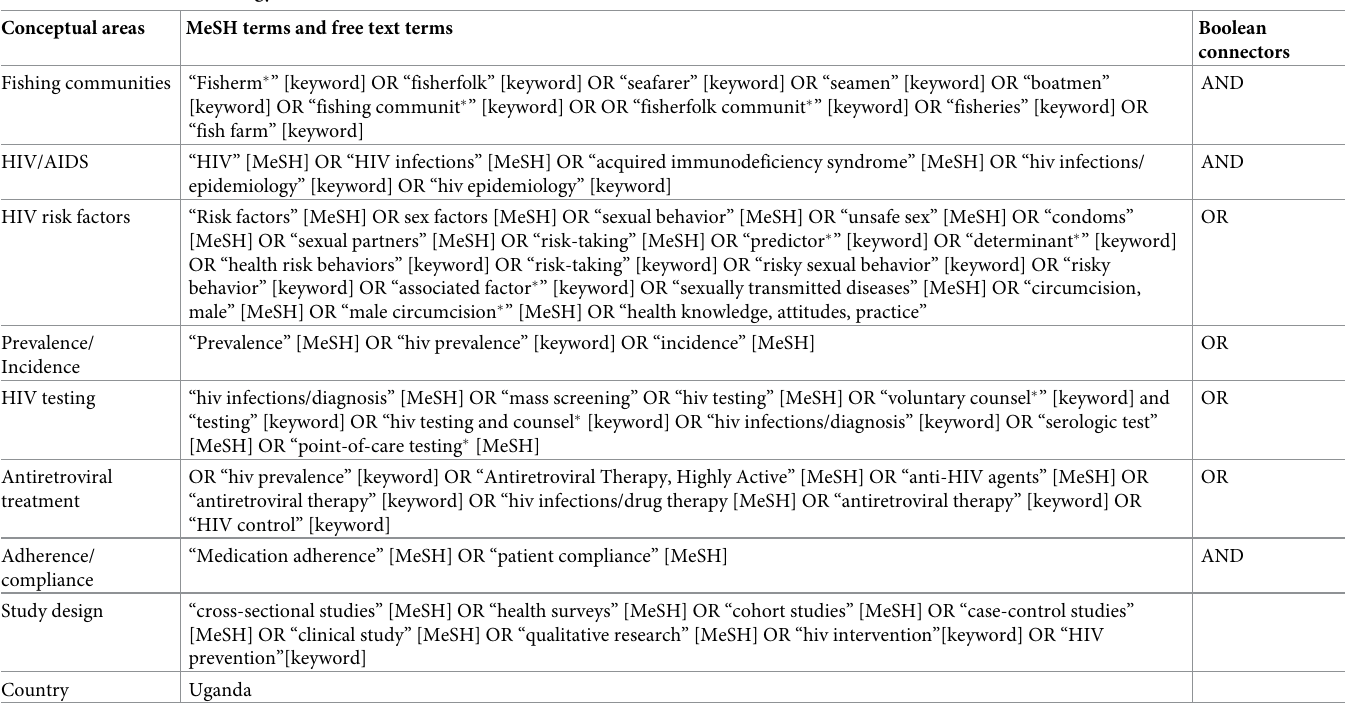
Table 1. PubMed search